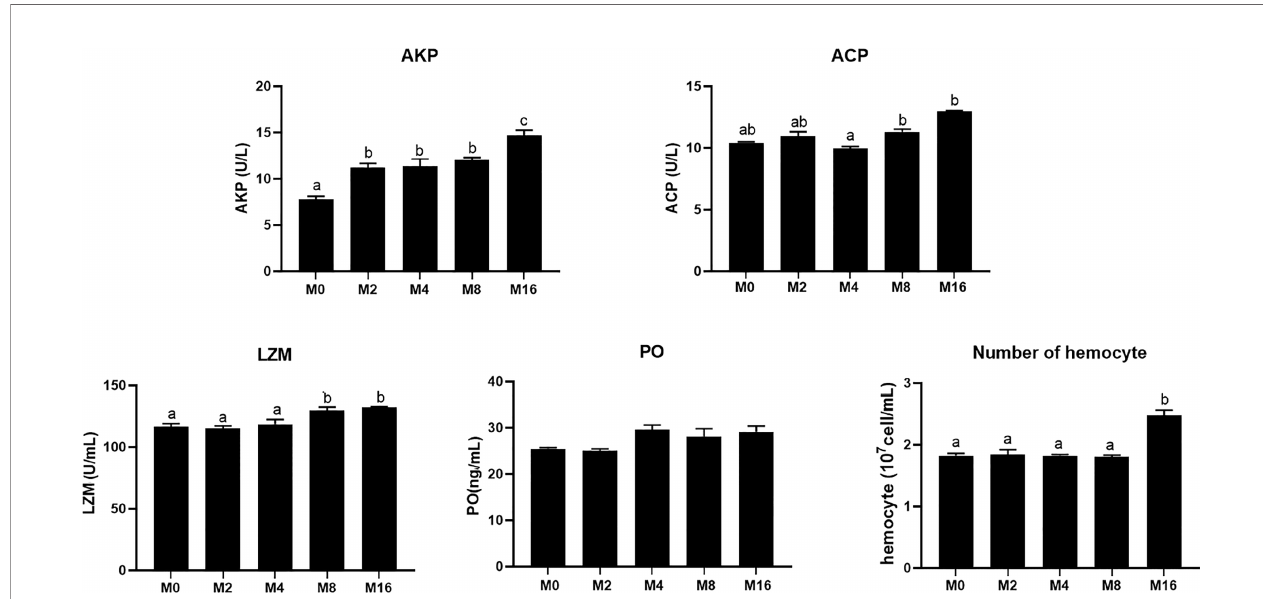
FIGURE 2 | Effects of dietary MOS on non-speci fi c immune indices in plasma and hemocyte counts of Litopenaeus vannamei . a,b,c Value bars not sharing the same superscript letter are signi fi cantly different as evaluated by Tukey ’ s test ( p < 0.05). ACP, acid phosphatase; AKP, alkaline phosphatase; LZM, lysozyme; PO, phenol